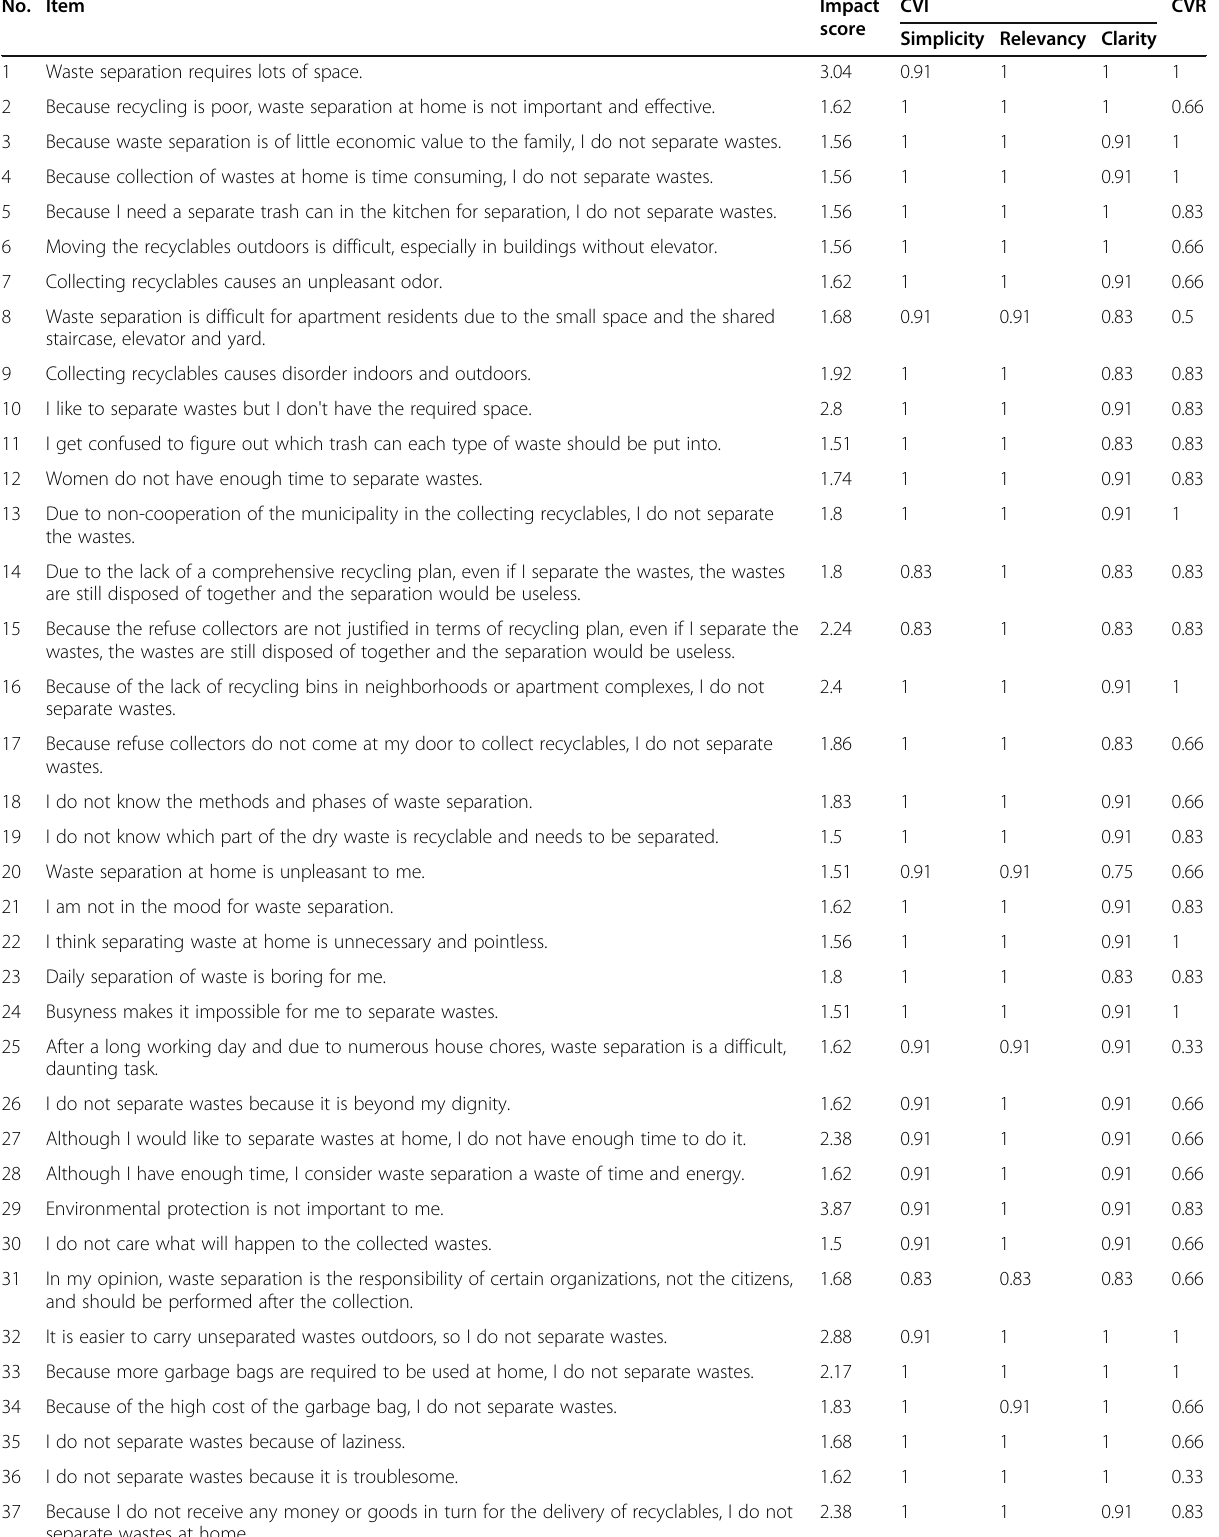
Table 1 Results of face and content validity of the instrument No.